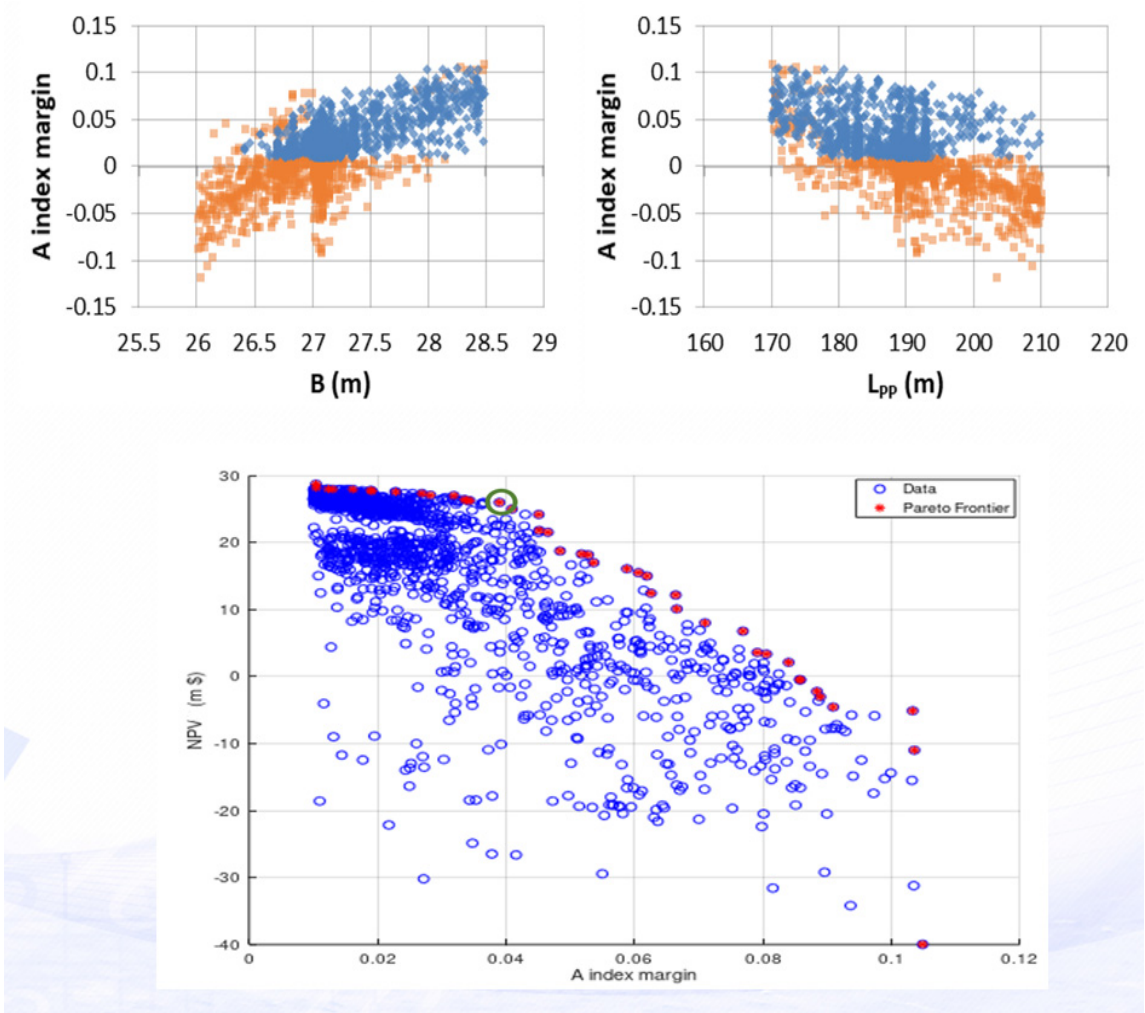
Figure 12. HOLISHIP Optimization RoPax [19].